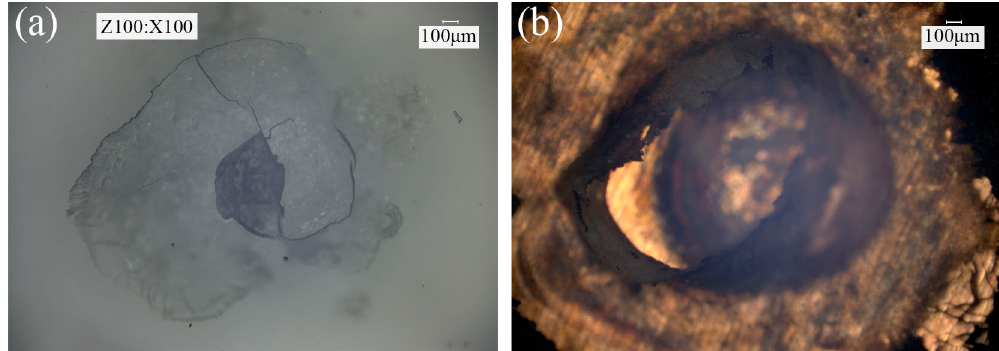
Figure 6. Surface morphology of polymethyl methacrylate (PMMA) and soft punch after impacted by 4 laser pulses, En = 1550 mJ: ( a ) cracks appear on the surface of PMMA; ( b ) ablative layer is completely vaporized and the soft punch is ablated.